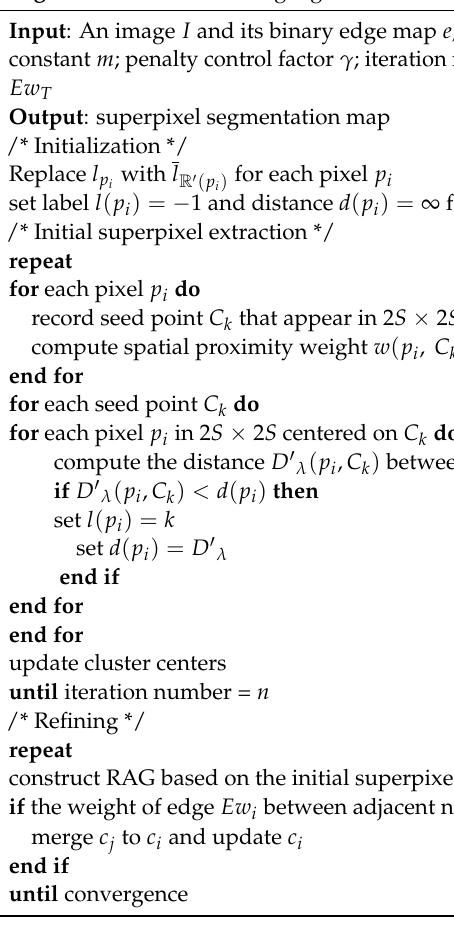
Algorithm 2. The clustering